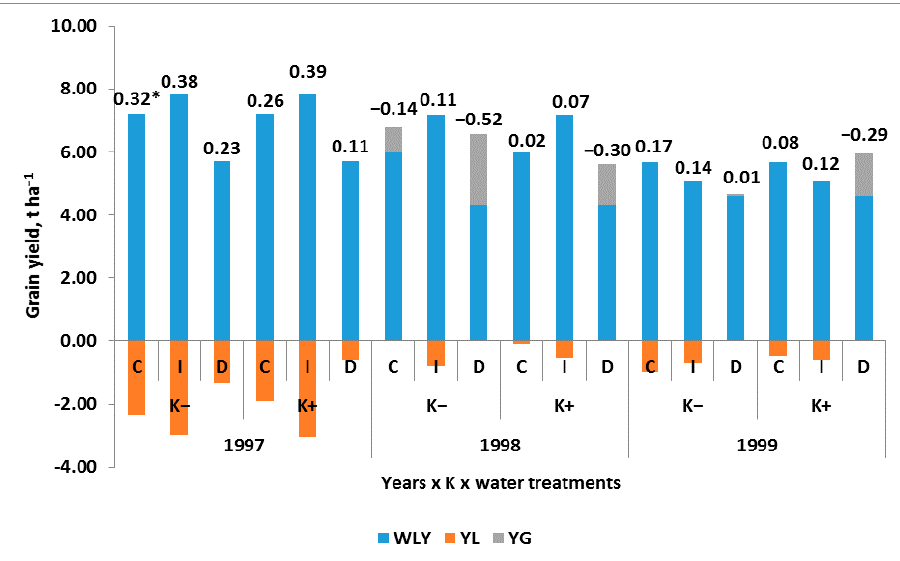
Figure 1. Graphical presentation of Water Limited Yield and loss/gain yield of winter wheat. Legend: WLY—water-limited yield; YL—yield loss; YG—yield gain; 0.32—the yield gap fraction; C—water control; I, D—plots irrigated or with imposed drought by water shortage during stem elongation and heading. (Author’s own result; unpublished) * yield gain ( − )/yield loss.